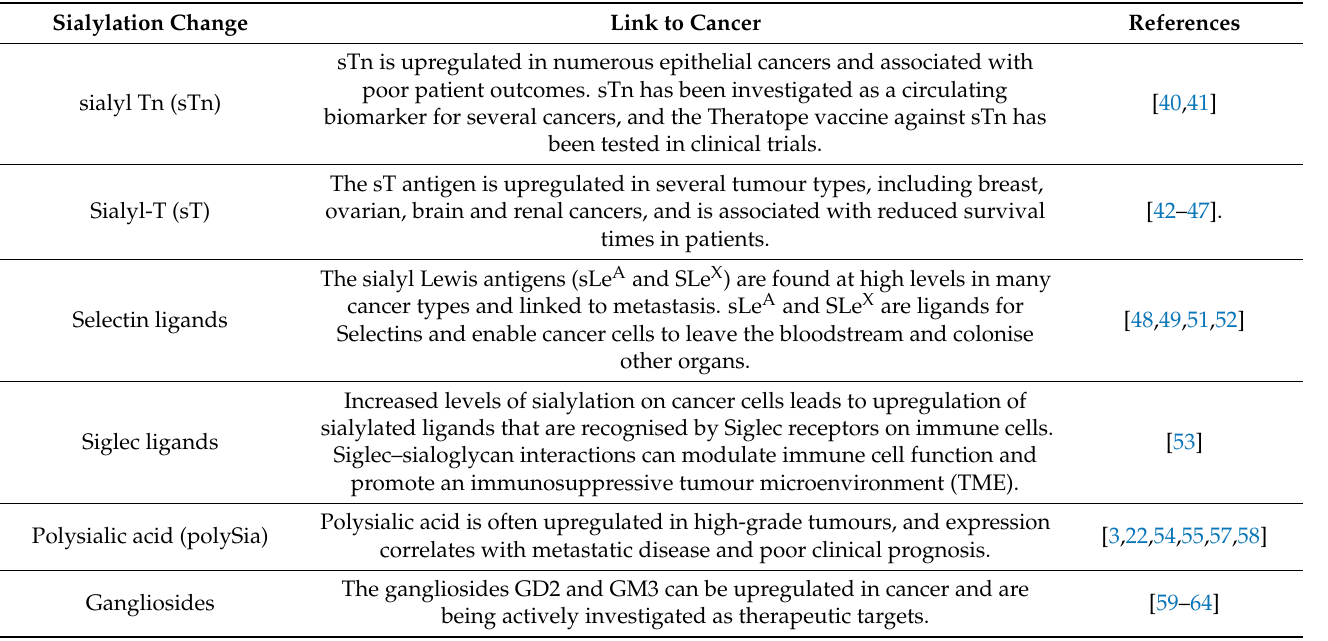
Table 1. Summary of sialylation changes in